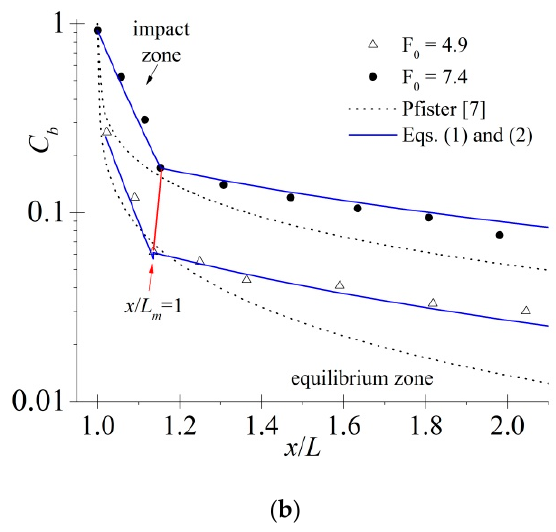
Figure 3. Bottom air concentration along the chute and compared with Pfister [7] ( a ): S2; ( b ): S5.